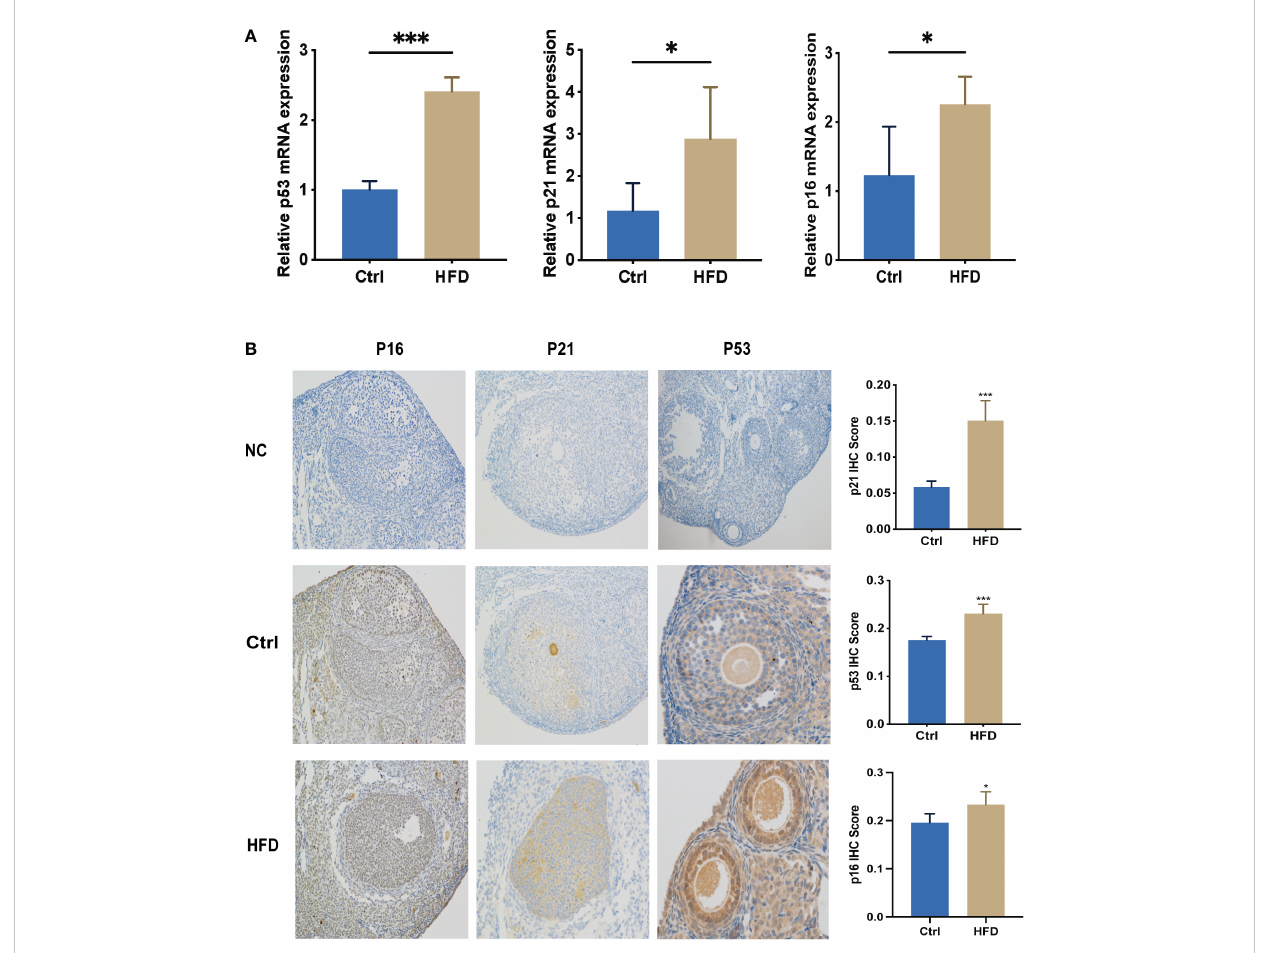
FIGURE 4 Levels of senescence-associated biomarkers in HFD-fed mice were greatly increased. (A) RNA was extracted from the ovaries of mice in Ctrl and HFD groups, n=3 at each time point and each group; unpaired t-test. (B) IHC of p16, p53, and p21 in Ctrl (n = 5) and HFD (n = 5) mouse ovaries. The error bars indicate the mean values ± SDs, unpaired t-test. *: P<0.05, ***: P<0.001 compared to “ Ctrl ”